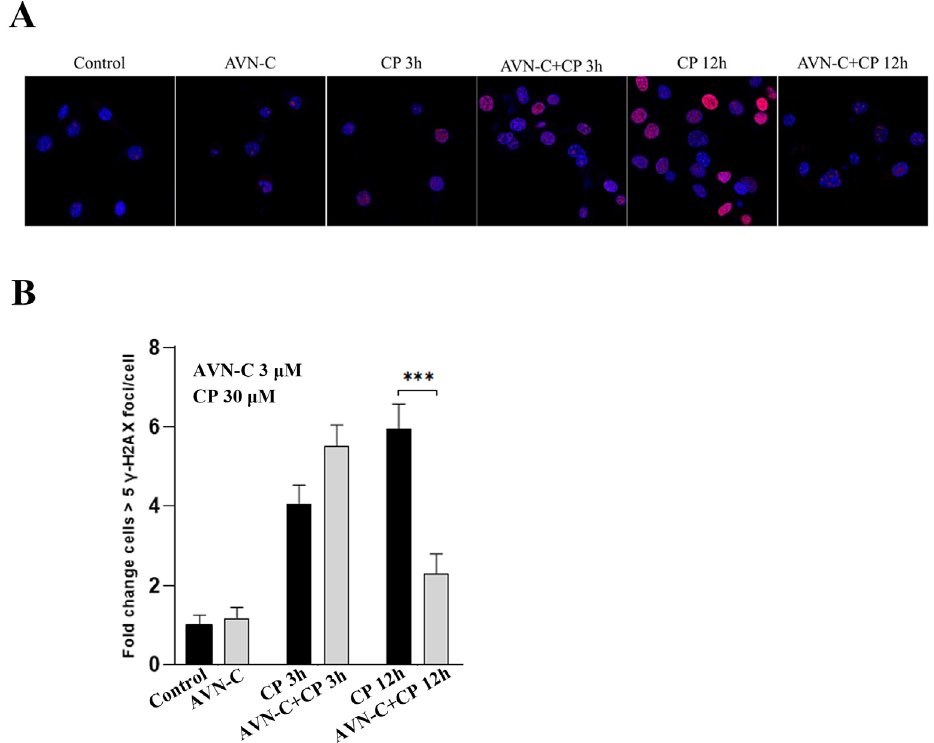
Figure 6. AVN-C prevents DNA damage caused by CP. AVN-C 3 µM and CP 30 µM were used